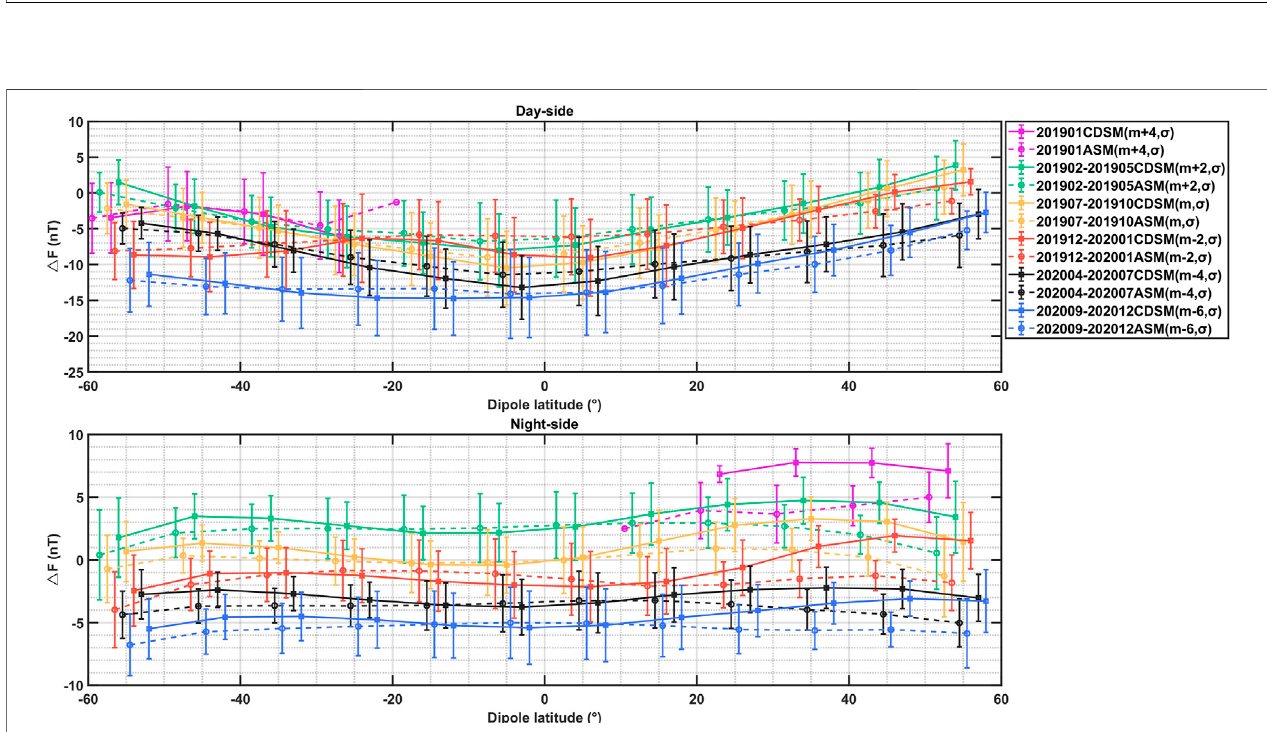
FIGURE 12 | Mean value and standard deviation analysis of Δ F along the dipole latitude in different periods (the error bars of CSES in these six periods in chronological order have been shifted +4nT, +2nT, 0nT, − 2nT, − 4nT, − 6nT in vertical direction and − 2 ° , − 1 ° , 0 ° , +1 ° , +2 ° , +3 ° in horizontal direction, and those of Swarm Bravo have been shifted +4nT, +2nT, 0nT, − 2nT, − 4nT, − 6nT in vertical direction and − 4.5 ° , − 3.5 ° , − 2.5 ° , − 1.5 ° , − 0.5 ° , +0.5 ° in horizontal direction, in order to allow a visual comparison, as labeled in the Figure legend).